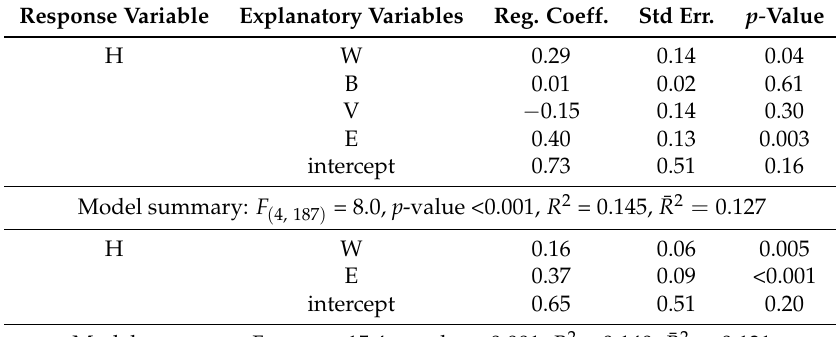
Table 2. Multivariate linear models for C = 8 to explain the Shannon index (H) from the SH measures (V: log-transformed global variability or MDC, W: log-transformed within-class variability, B: log-transformed between-class variability, E: entropy) computed from multitemporal data. Reg. Coeff. is the regression coefficient; Std Err. is the standard error; F stands for the F-value with degrees of freedom in brackets; R 2 is the coefficient of determination; and ¯ R 2 is the adjusted coefficient of determination. Response Variable Reg.